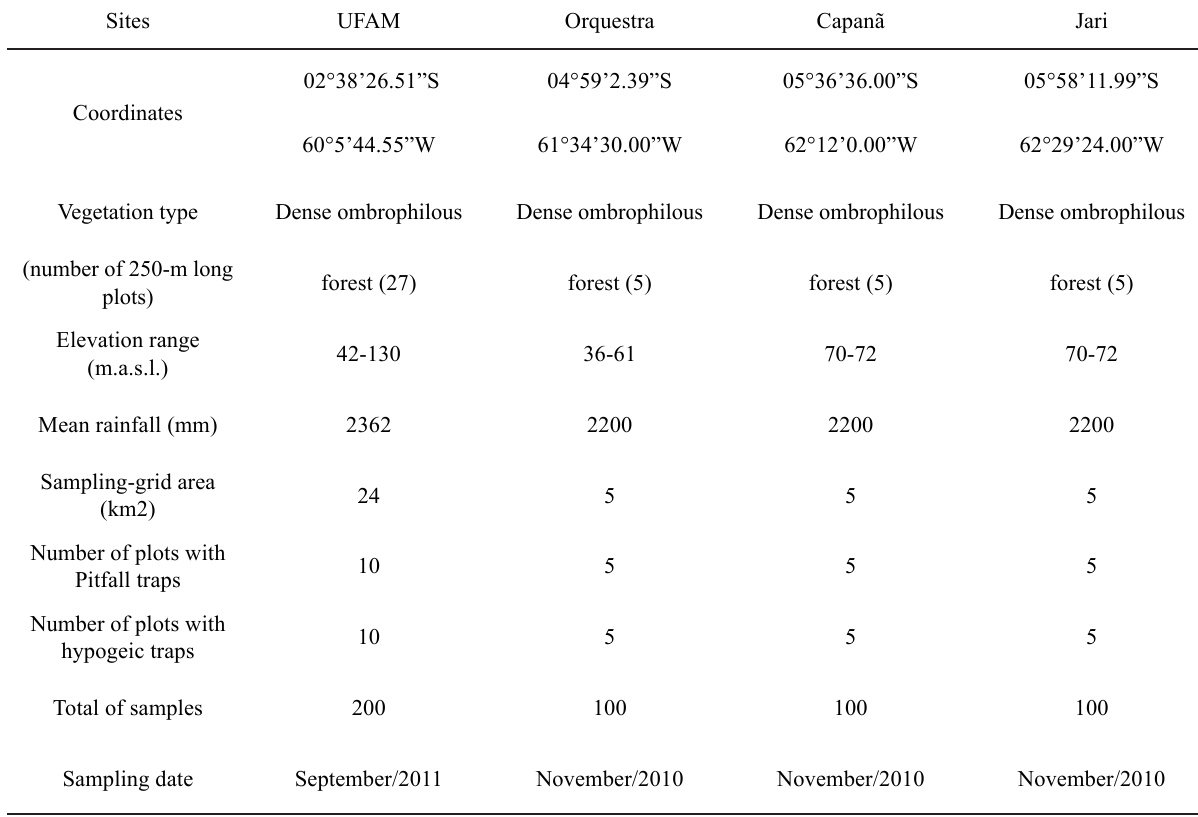
Table 1 . Vegetation, rainfall, elevation range, number of samples and sampling techniques in four sites in the Brazilian Amazon. Sites UFAM Orquestra